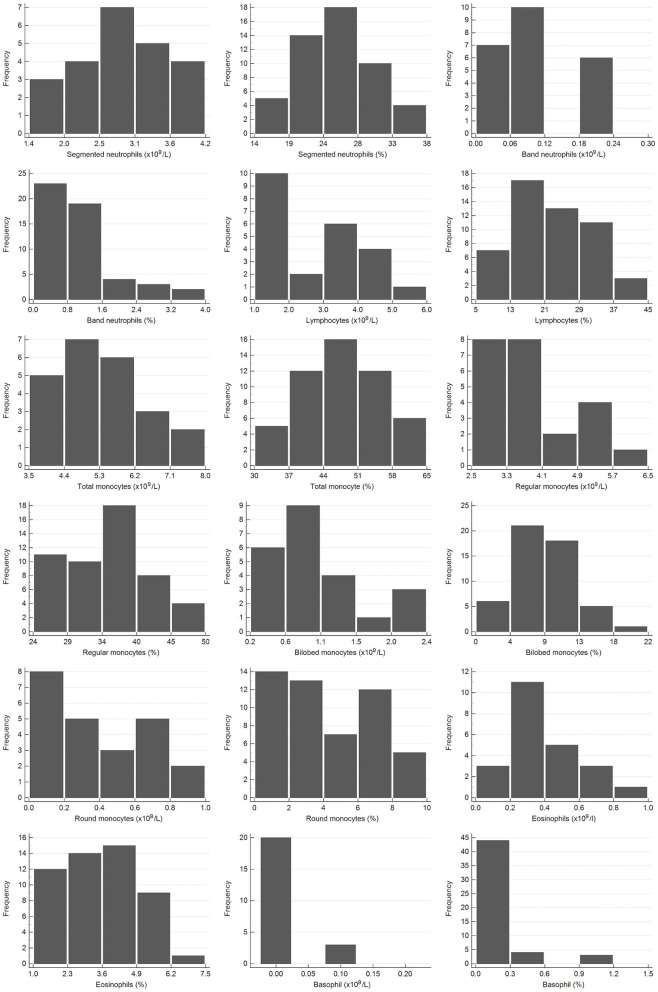
Histograms showing the distribution of results for leukocytes from the African elephant (Loxodonta africana) for the scil Vet abc or Horiba ABX Micro ESV60 and manual differential leukocyte counts. The x-axis represents the measurand result; the y-axis represents the frequency of these values occurring.